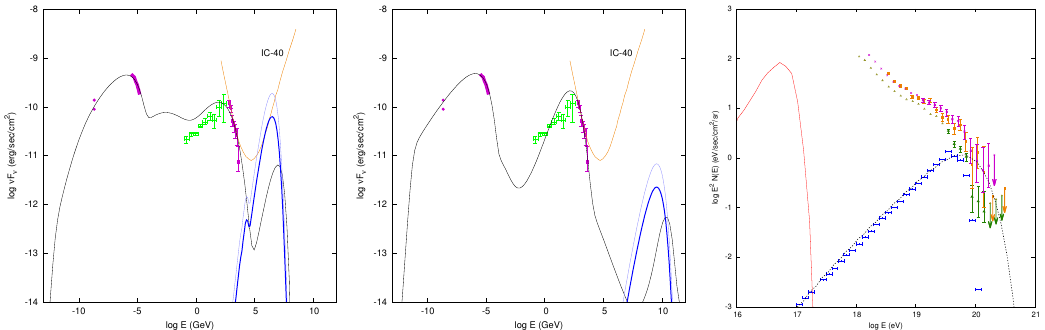
Figure 2. Left and Middle panels: spectra of photons (black line) fitting the March 22nd/23rd 2001 observation of Mrk 421 (purple points), neutrinos of all flavors (grey line), and ν µ + ¯ ν µ flux (thick blue line) according to the LH π and the LHs models, respectively. Fermi observations (green points) are not simultaneous with the rest of the data, and are thus not included in the fit. The 40-String IceCube limit [11] for ν µ is plotted with an orange line. Right panel: cosmic-ray (proton) spectra resulting from neutron decay and obtained within the LH π (red line) and LHs (blue dashed line) models. For the latter, the cosmic-ray spectra obtained after taking into account propagation effects using the numerical code CRPropa 2.0 [12] are also shown (blue crosses). Different symbols are used for the cosmic-ray energy flux measurements by Auger, HiRes-I, and Telescope